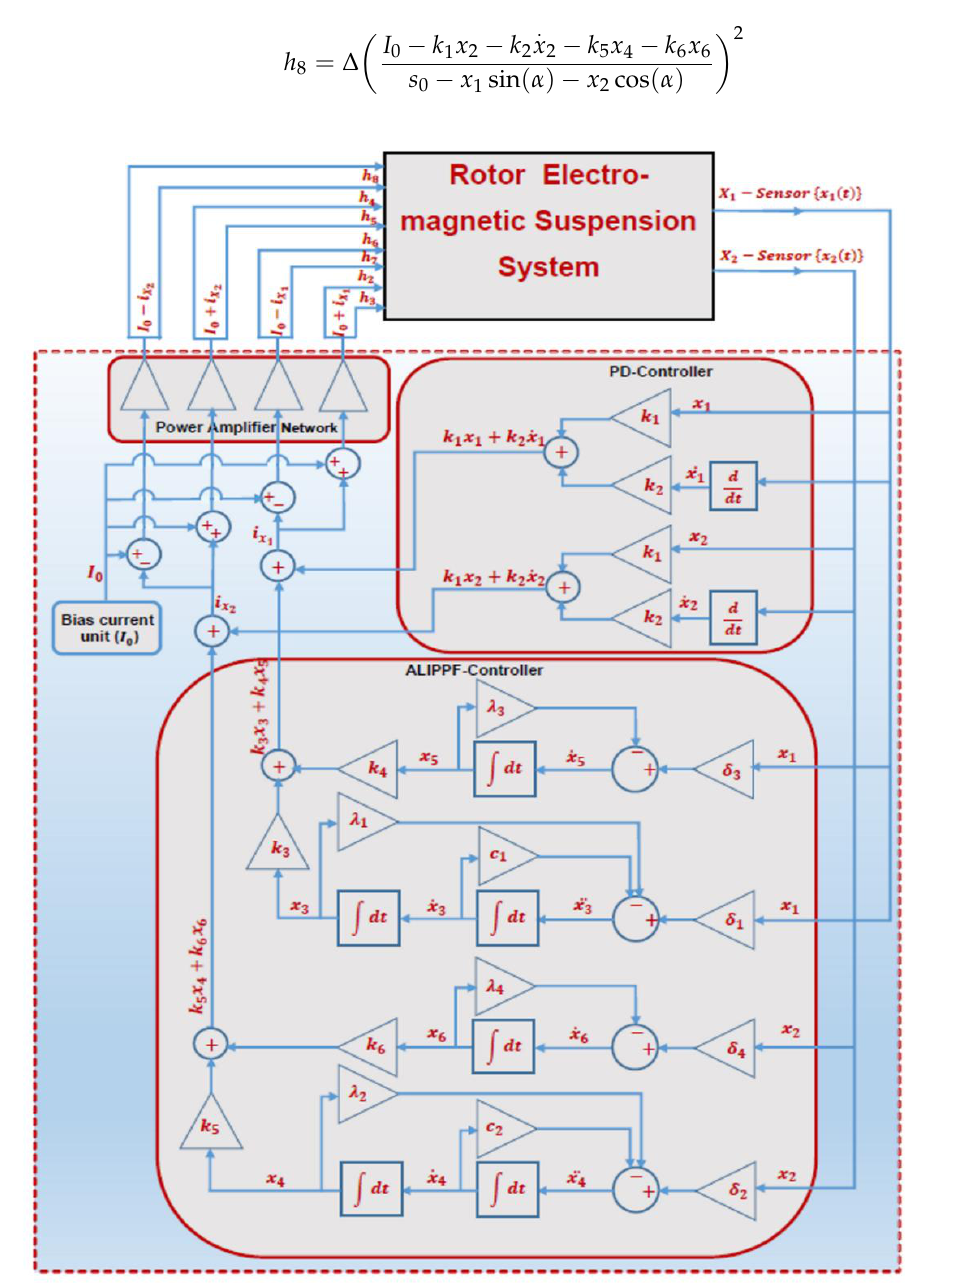
Figure 2. The schematic diagram shows the interconnection between the proposed LIPPF-controller and the electro-magnetic suspension system.